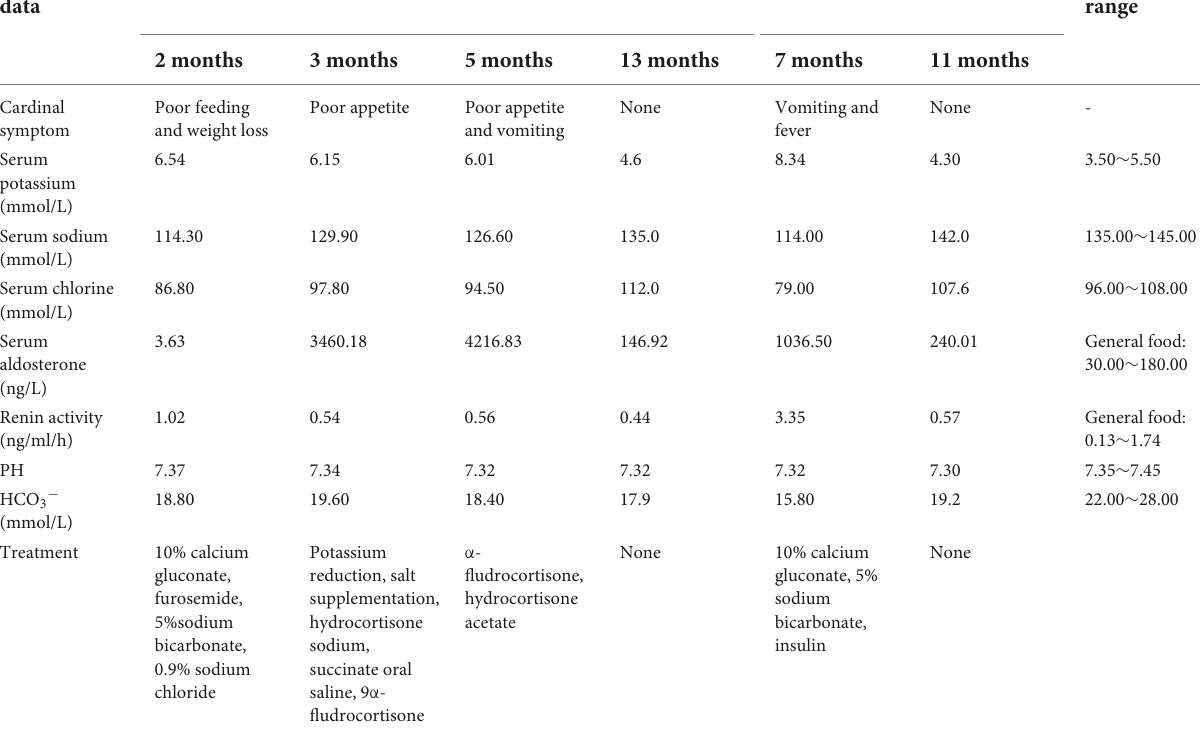
TABLE 1 Timeline with relevant data of the two transient pseudohypoaldosteronism cases. Relevant